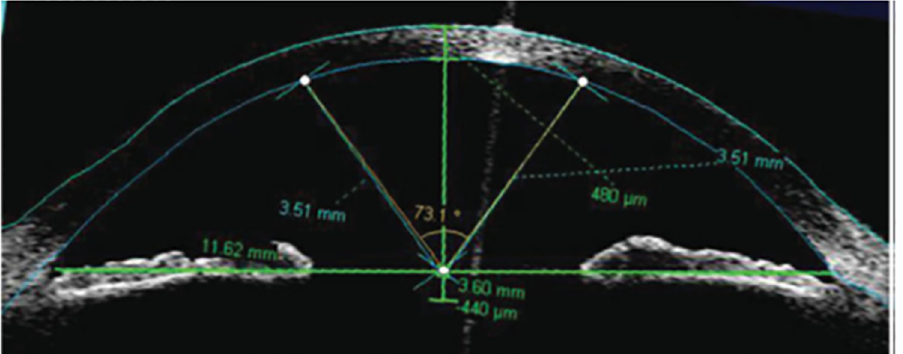
Fig 6. Images of posterior corneal curvature